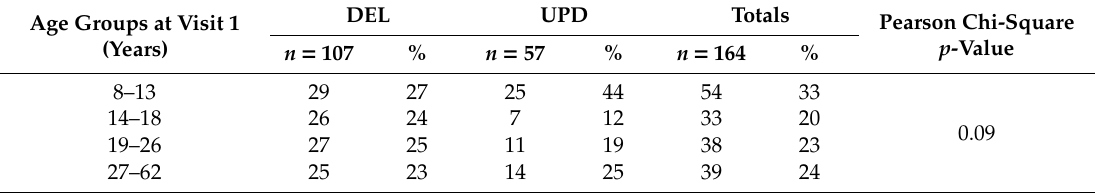
Table 3. Age groups at visit 1 by deletions (DEL) and uniparental disomy (UPD) genotypes. Age Groups at Visit